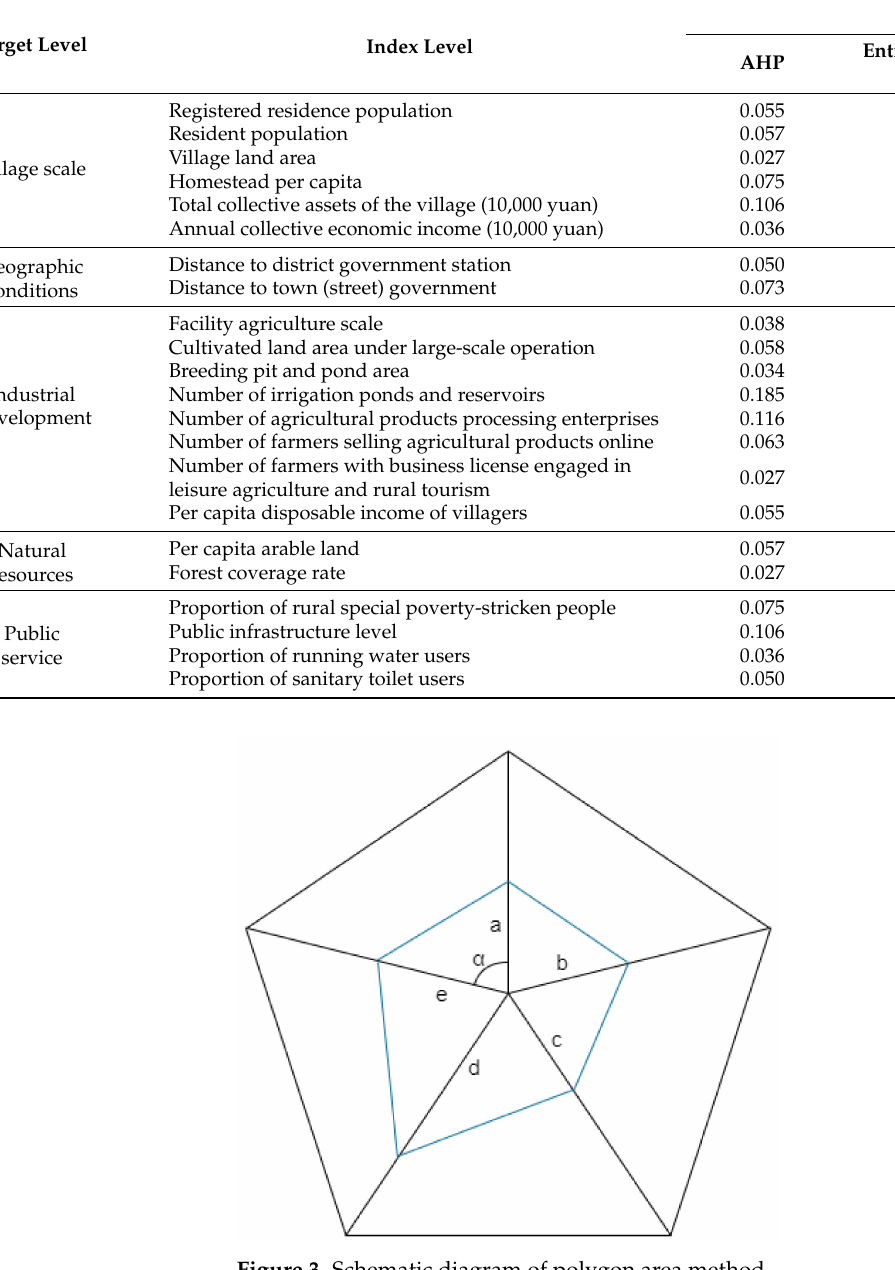
Figure 3. Schematic diagram of polygon area